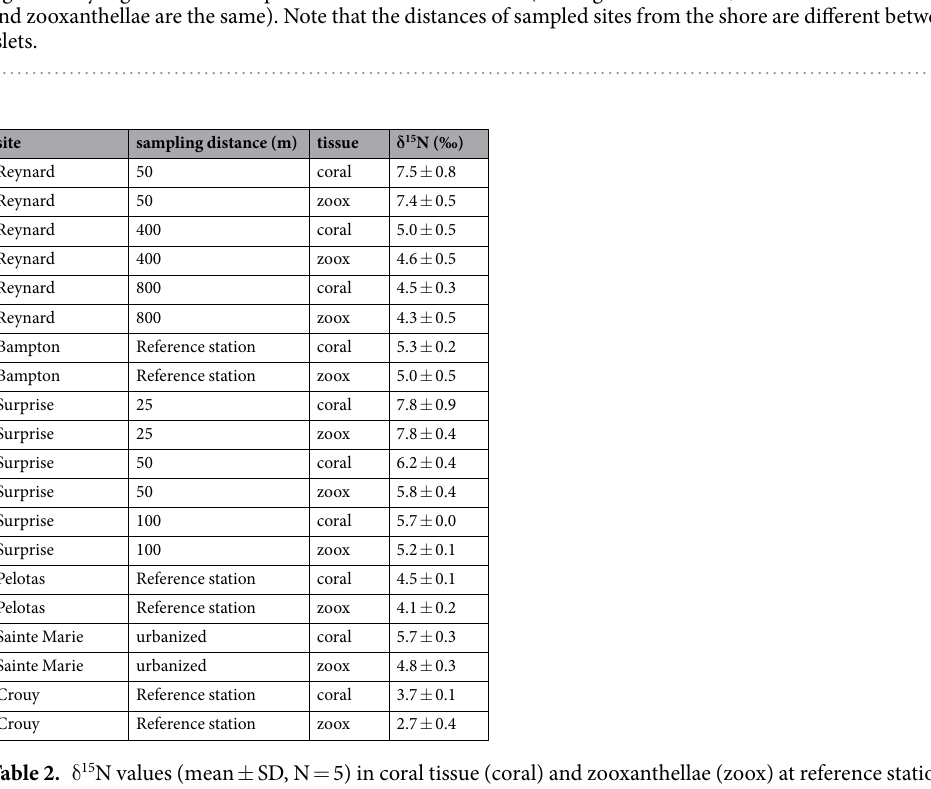
Table 2. δ 15 N values (mean ± SD, N = 5) in coral tissue (coral) and zooxanthellae (zoox) at reference stations (50 m from the reef crest), Reynard and Surprise islets. Values in Nouméa stations (Sainte Marie and Crouy) are also